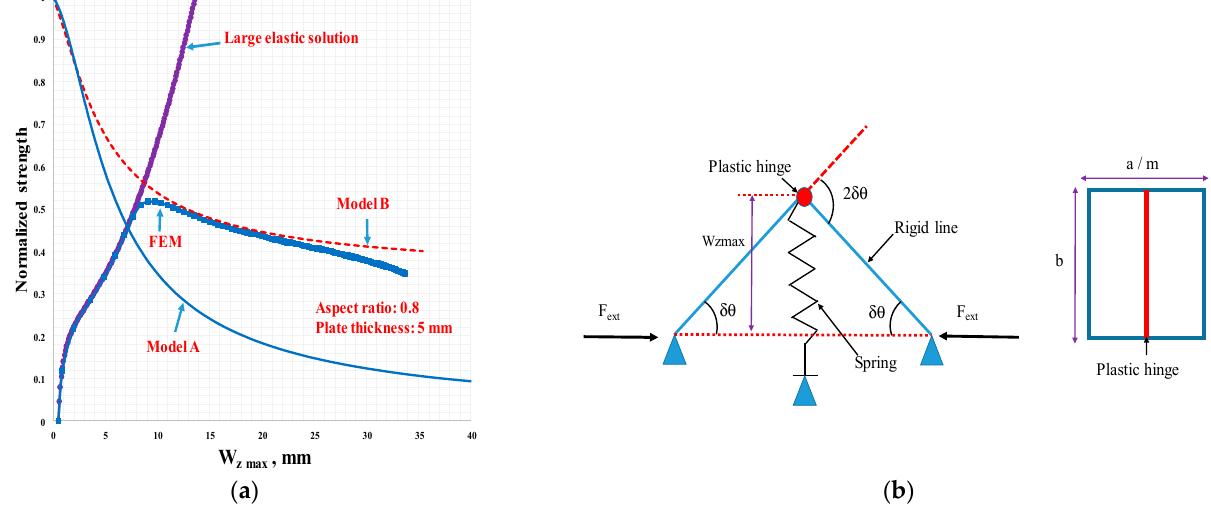
Figure 2. ( a ) Normalized strength and mid-plate vertical displacement, W z , relationship; ( b ) simple rigid plastic solution.